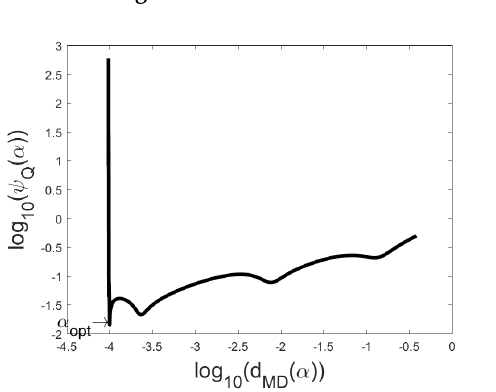
Figure 1. L-curve for Baart.